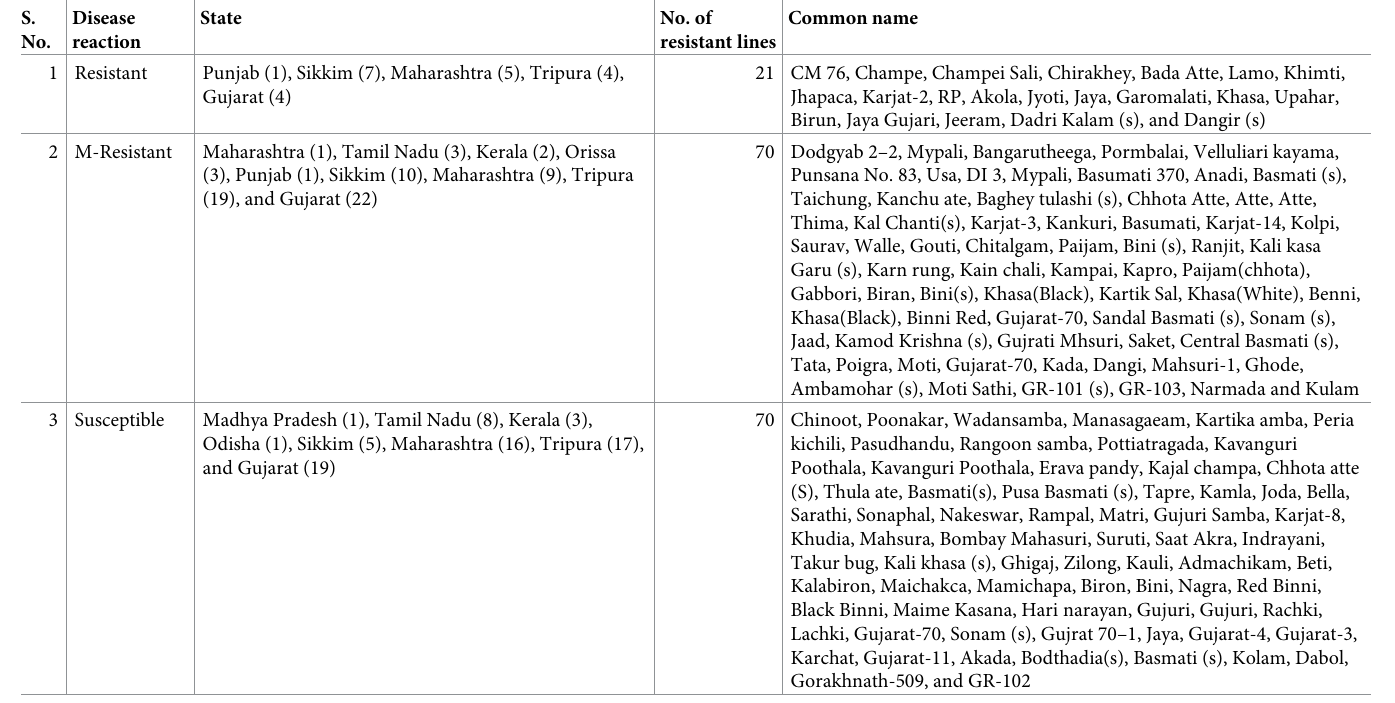
Table 2. Disease reactions of all India landraces for leaf blast resistance in the uniform blast nursery. S. Disease State No. of No. reaction